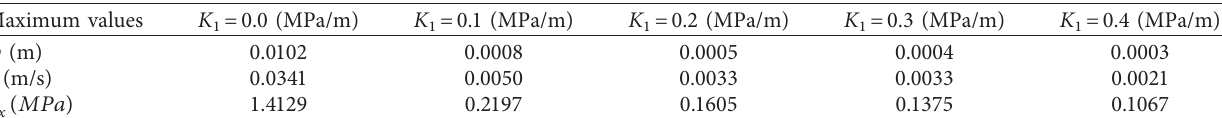
Figure 10: Deflections of the central point of the plate versus time for different Winkler foundation stiffness K versus time, (b) velocity v versus time, and (c) stress σ x versus time. Table 8: Maximum deflections, velocities, and stress of the plate central point. Maximum